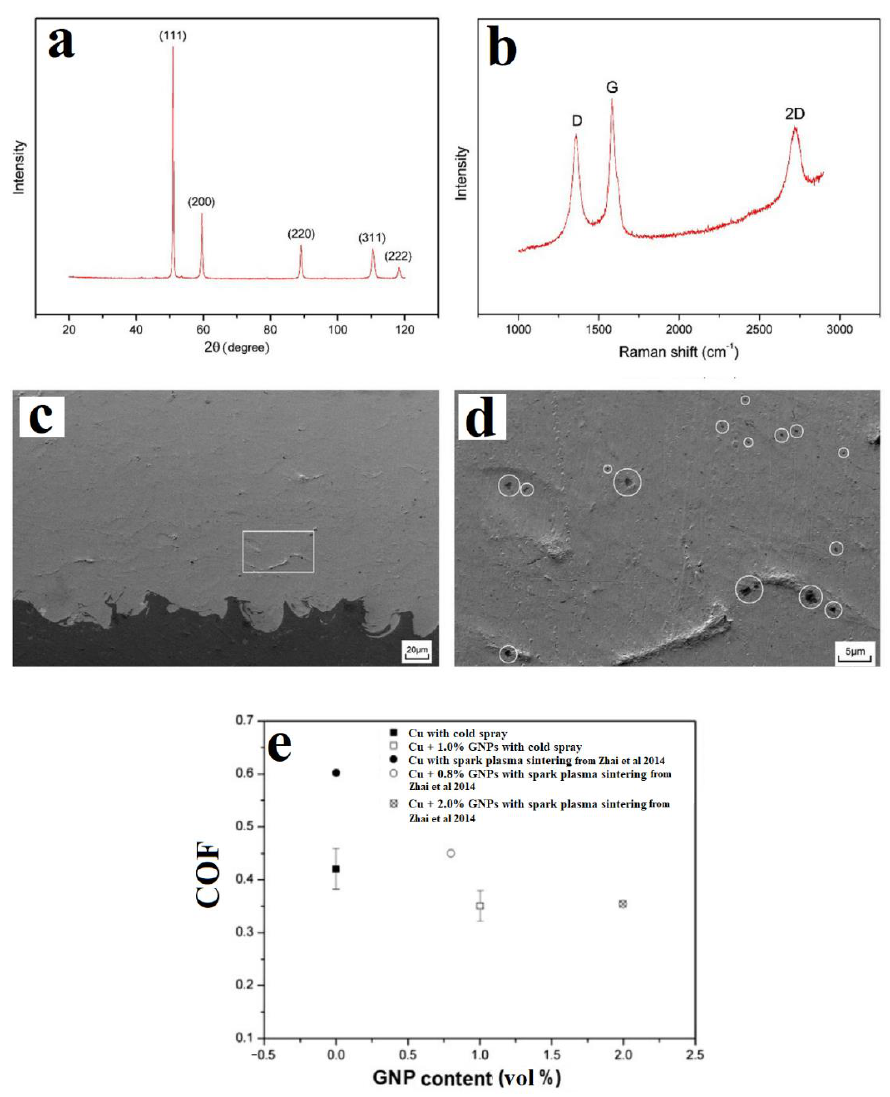
Figure 2. Analysis of milled Cu (1 vol.%)/GNP feedstock: ( a ) XRD and ( b ) Raman spectra. ( c ) SEM image of the CS Cu/GNP coating exhibiting good coating characteristics, ( d ) high-magnification SEM image showing good inter-particle bonding between Cu and GNP phases, and ( e ) coefficient of friction (COF) of the coatings. Presented with permission from [49] benchmarked with data from Zhai et al. [52].